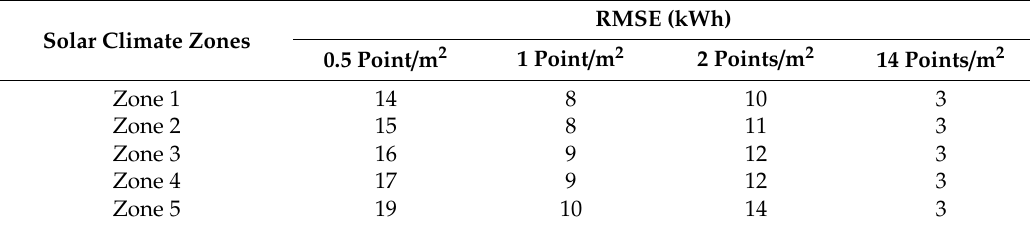
Table 15. Average daily electrical energy loss (kWh) due to the error in the estimation of the rooftop area for di ff erent point cloud densities: industrial buildings with a gable roof of 400 m 2